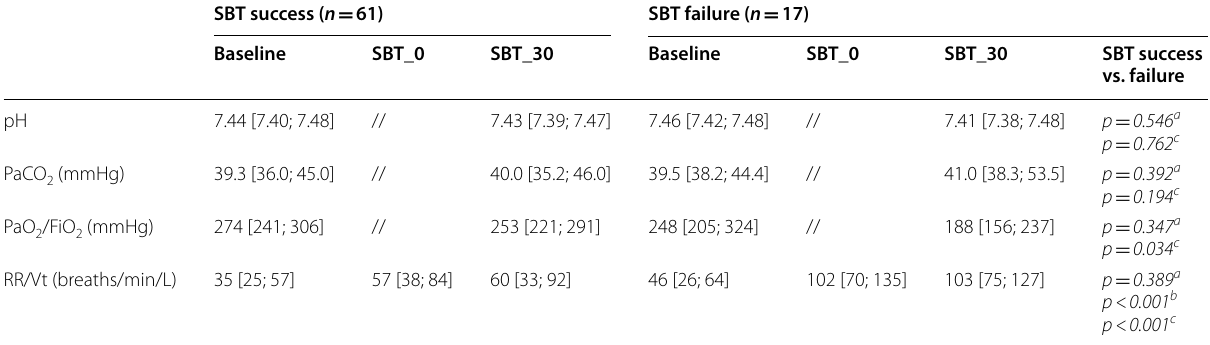
SBT, Spontaneous Breathing Trial; SBT_0, first 5 min after the beginning of the SBT; SBT_30, last 5 min of the SBT; PaCO 2 , arterial partial pressure of carbon dioxide; PaO 2 /FiO 2 , arterial partial pressure to inspired fraction of oxygen ratio; RR/Vt, respiratory rate to tidal volume ration //Data not present a Comparison between groups within baseline b Comparison between groups within SBT_0 c Comparison between groups within SBT_30. According to Bonferroni correction, the threshold for statistical significance is p < 0.025 for pH, PaCO while p < 0.017 for